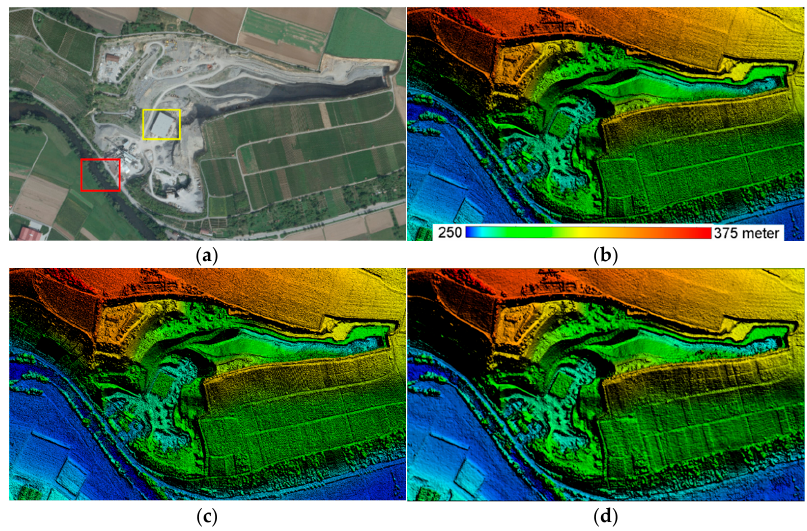
Figure 17. Results on Vaihingen/Enz subset: ( a ) true orthophoto; ( b ) ground truth; and ( c , d ) DSMs generated by SURE and SGVLL, respectively.